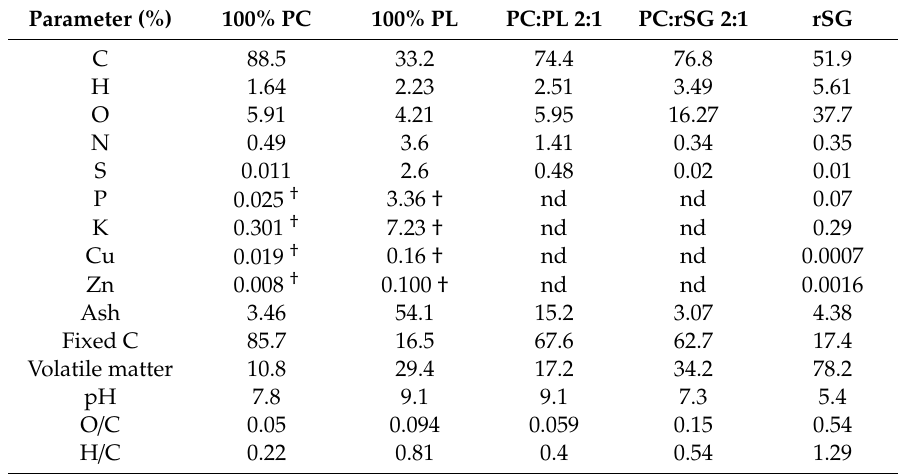
Table 1. Designer biochar and compost characteristics (PC = pine chip; PL = poultry litter, rSG = raw switchgrass as compost; nd = not